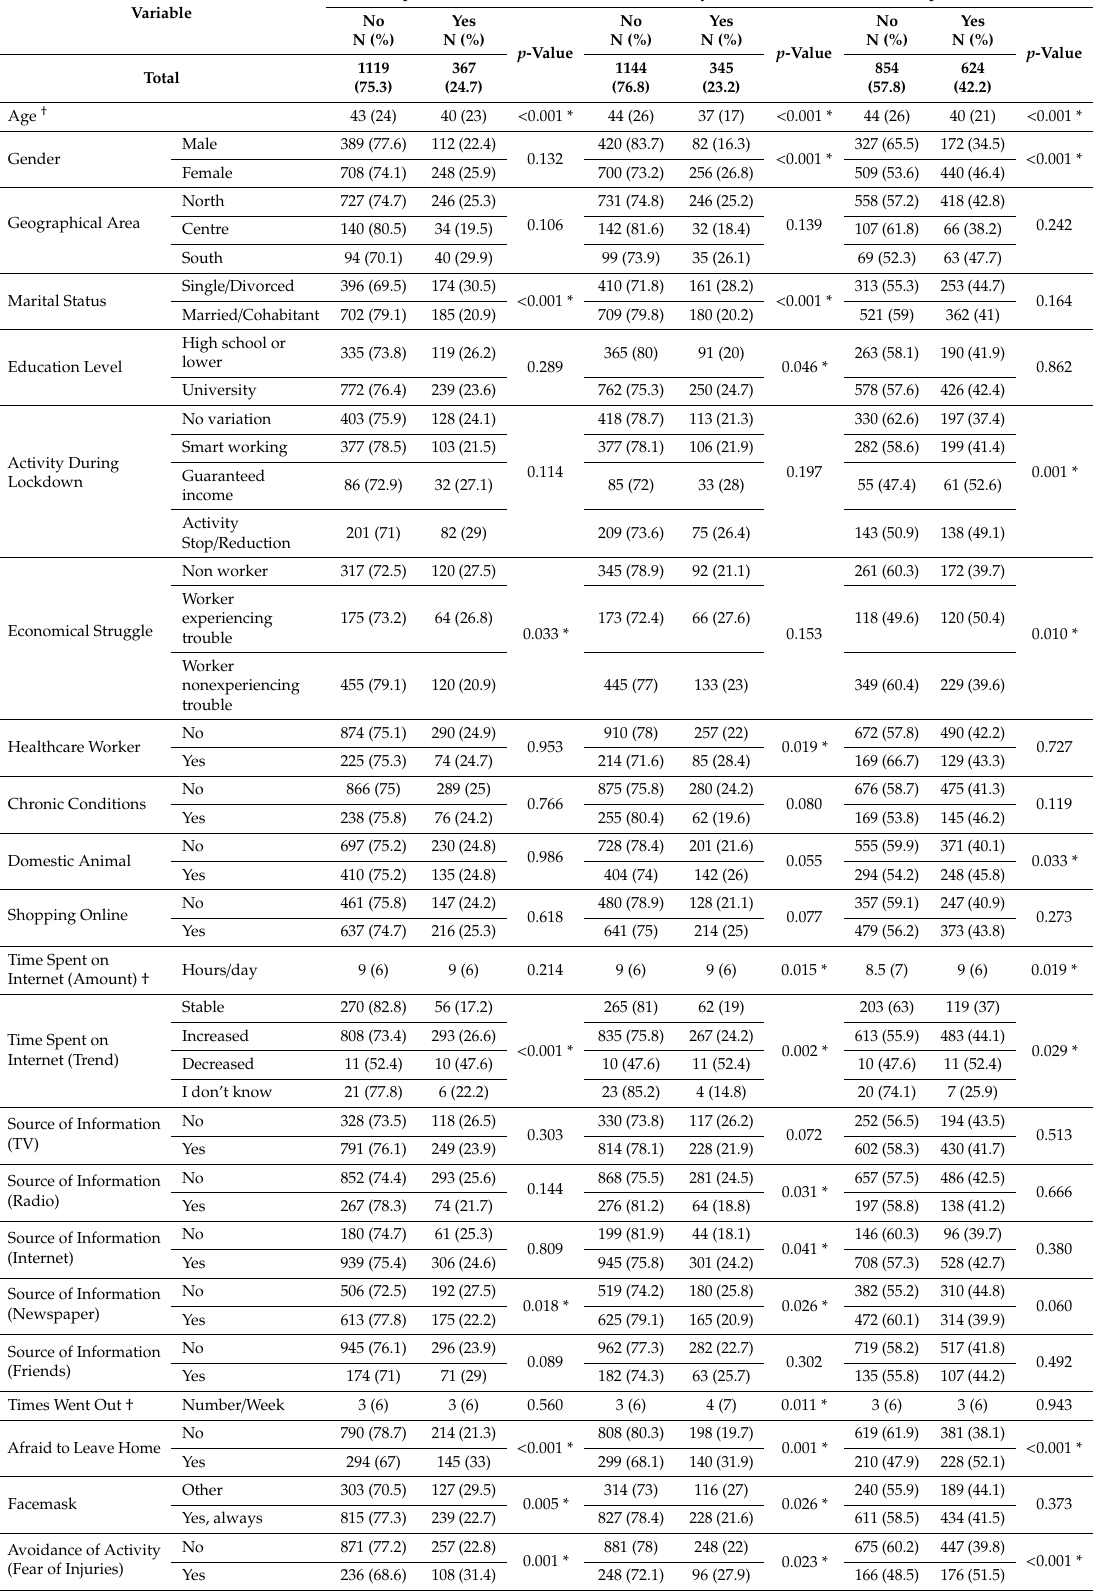
Table 2. Description of the sample stratified according to Depression, Anxiety and Sleep